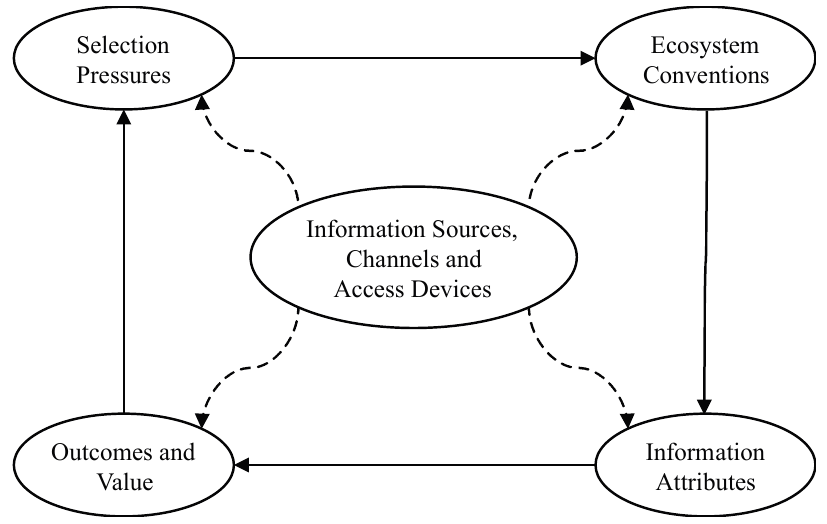
Figure 1. The Factors Affected by Digital